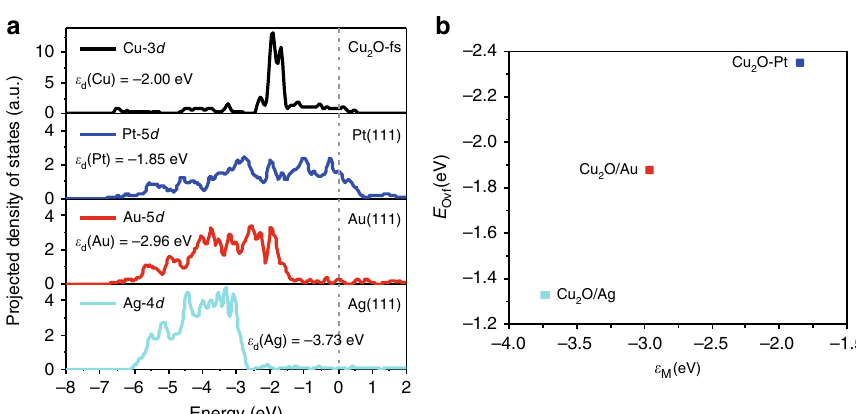
Fig. 7 Electronic interaction between Cu 2 O-fs and M(111). a Density of states projected on d orbitals of Cu atoms on the edge of Cu 2 O-fs and M atoms from the surface layer of M(111) (M = Pt, Au, Ag) and their corresponding d band centers. The grey dashed line marks the Fermi level. b E Ovf for O atoms at the edge of Cu 2 O/M as a function of d band center of